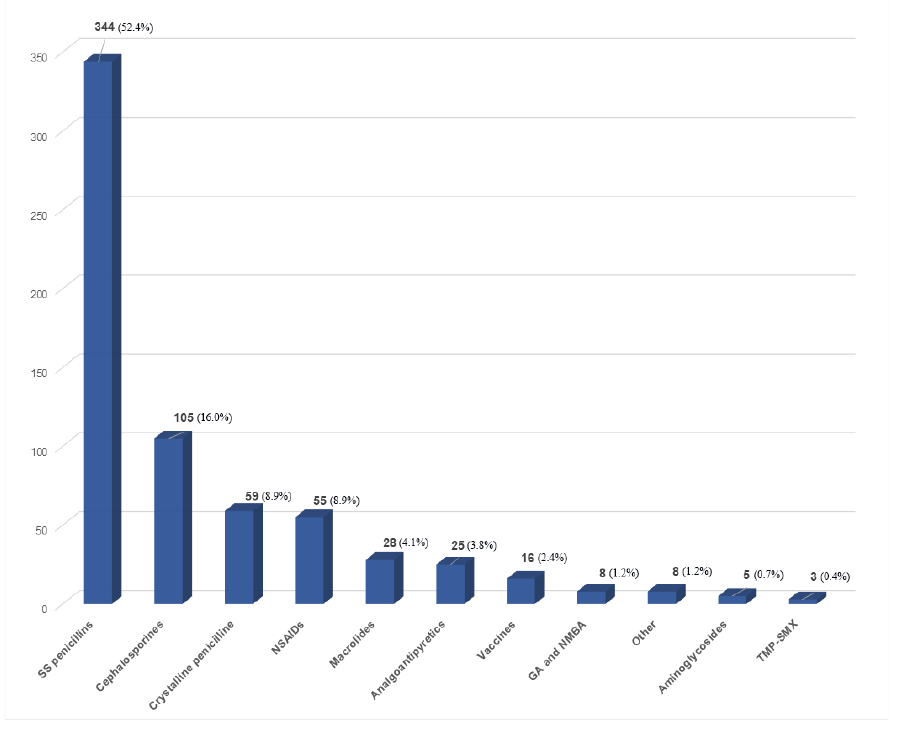
Figure 1. Suspected DHRs to specific drug classes (data obtained from patients’ medical histories). Figure DHRs — Drug hypersensitivity reactions; SS penicillins — semi-synthetic penicillins; NSAIDs — non-steroidal anti-inflammatory drugs; GA — general anesthetics; NMBA — neuromuscular blocking agents; TMP-SMX — trimethoprim-sulfamethoxazole.